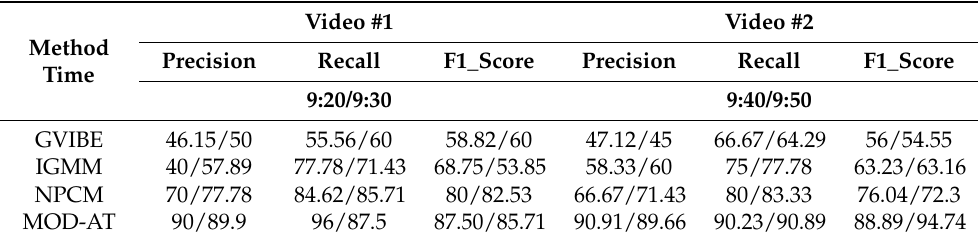
Figure 10. Experimental results of videos #1 and #2 for algorithm comparison: ( a ) comparison of number of correct detections for video #1; ( b ) TP and TN error box charts of video #1; ( c ) comparison of number of correct detections for video #2; ( d ) TP and TN error box charts of video #2. Table 4. Comparison of single-frame indicators between videos #1 and # 2.